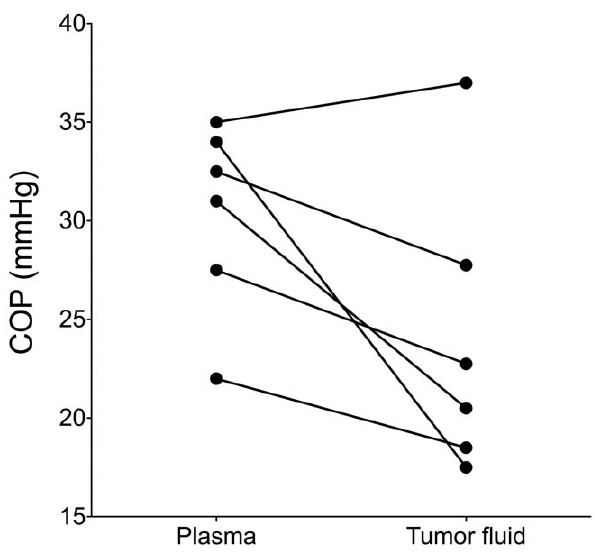
Figure 3. Colloid osmotic pressure (COP) in plasma and tumor fluid samples. COP was measured in paired plasma and tumor fluid samples using a colloid osmometer with a 30 kDa cut off-membrane. Corresponding pressure measurements in plasma and tumor fluid have been connected.